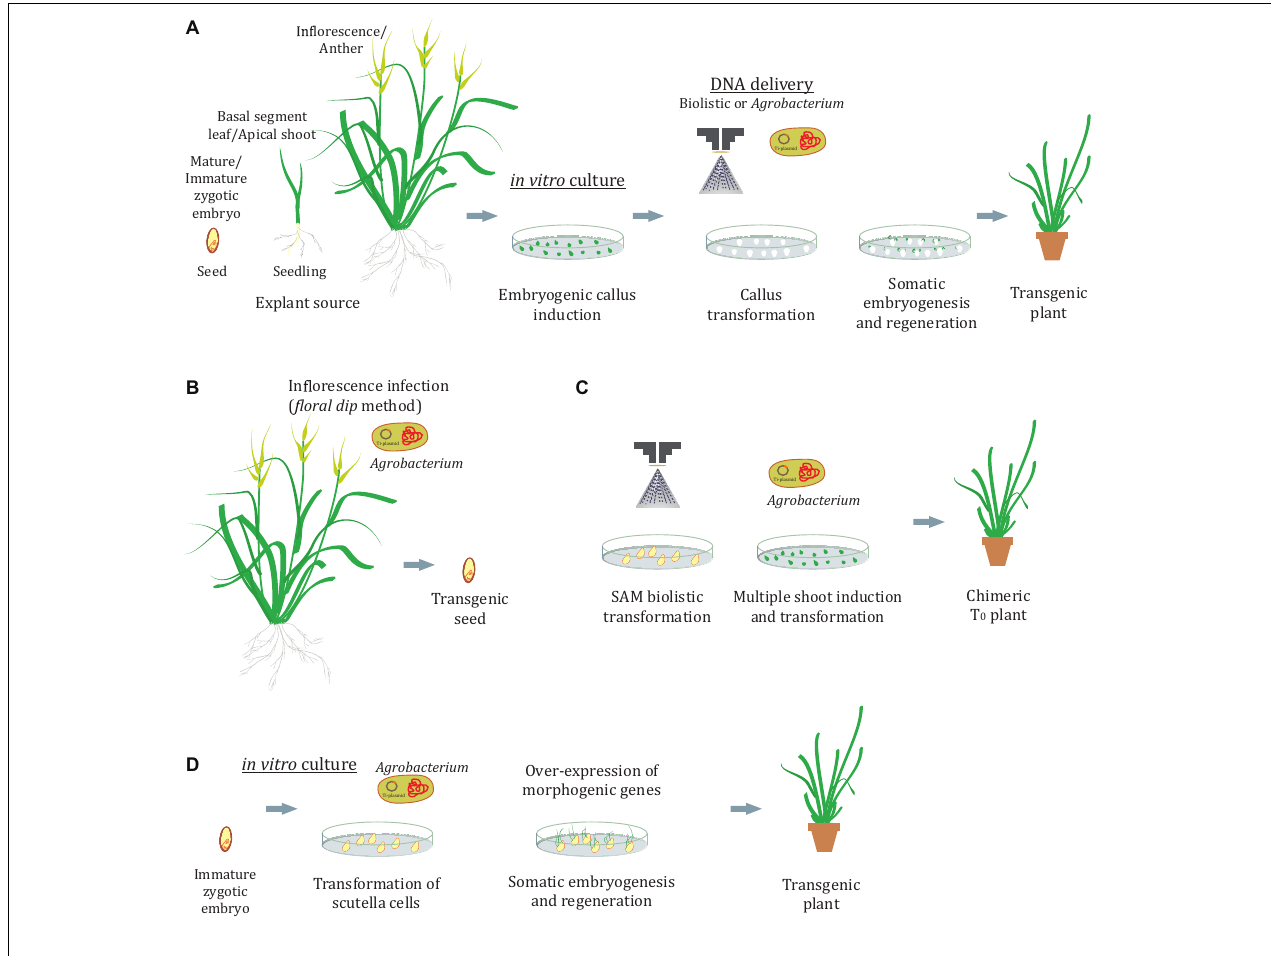
FIGURE 1 | Genetic transformation in grasses. (A) Transformation of calli and regeneration by indirect somatic embryogenesis. (B,C) In planta methods by floral dip (B) or shoot apical meristem transformation (C) . (D) Transformation of scutella cells with morphogenic regulators and regeneration without the callus phase by direct somatic embryogenesis. SAM, shoots apical